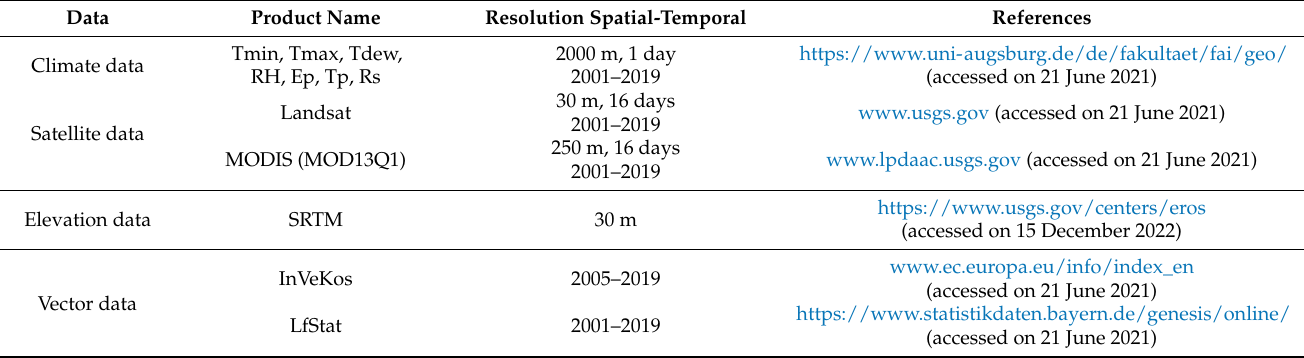
Table 1. A summary of the collected datasets for fusion modelling and winter wheat’s (WW) and oil- seed rape’s (OSR) crop modeling. The satellite data used for fusion and crop modelling are Landsat 5, 7, and 8 and Moderate Resolution Imaging Spectroradiometer (MODIS) MOD13Q1; the climate parameters are minimum temperature ( ◦ C) (Tmin), maximum temperature ( ◦ C) (Tmax), dewpoint temperature ( ◦ C) (Tdew), relative humidity (%) (RH), evaporation (mm) (Ep), transpiration (mm) (Tp), and solar radiation (MJm − 2 day − 1 ) (Rs); Shuttle Radar Topography Mission (SRTM) elevation data of Bavaria; InVeKos data provides the fields of WW and OSR for Bavaria from 2005 to 2019; the Bayerisches Landesamt für Statistik (LfStat) data provides the crop yield information (dt/ha) of WW and OSR at district level in Bavaria from 2001 to